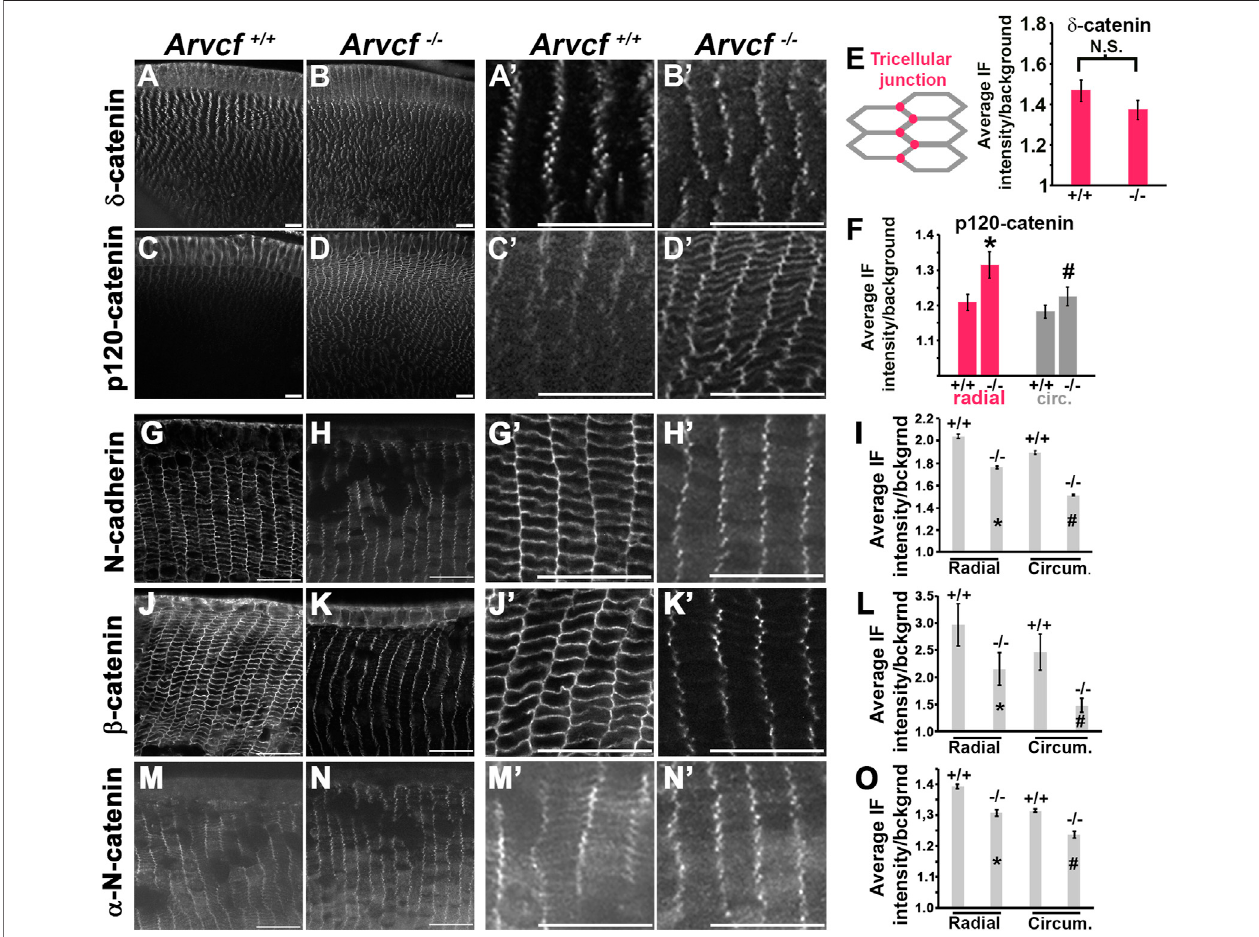
FIGURE 4 | Arvcf is required for adherens junction protein membrane localization. (A – D) Equatorial cryosections of juvenile mouse lenses (P7) from Arvcf +/+ (A,C) or Arvcf − / − (B,D) animalsimmuno fl uorescentlylabeledfor δ -catenin (A – B) orp120-catenin (C – D) .Magni fi edviewsofthelens fi bercellswithin~50 μ mofthelenssurface from (A – D) aredisplayedinthepanelsimmediatelytotheright. (E – F) Thegraphsrepresentthemeanandstandarderroroftricellular fl uorescentintensityof δ -catenin (E) or the bicellular junctionalintensity ofp120-catenin (F) . The asterisks/#symbols represent statistically signi fi cant differencesbetween the control and experimental gropus ( p < 0.05). (G – O) Equatorial cryosections of juvenile (P30) day old lenses from Arvcf +/+ (G,J,M) or Arvcf − / − (H,K,N) mice were immuno fl uorescently labeled with antibodiesspeci fi cforN-cadherin (G – H) , β -catenin (J – K) ,and α N-catenin (M – N) .Magni fi edviewsofthelens fi bercellswithin~50 μ mofthelenssurfacearedepictedto the right. The graphsin (I,L,O) represent the mean and standard error ofjunctionalmeasurements taken asshown for Figure 3N . The asterisks/# symbols representsa statistically signi fi cant difference from the control group ( p < 0.05). A Plan-Apochromat ×40/1.3 Oil objective with wide- fi eld fl uorescent microscope was utilized. Scalebar = 25